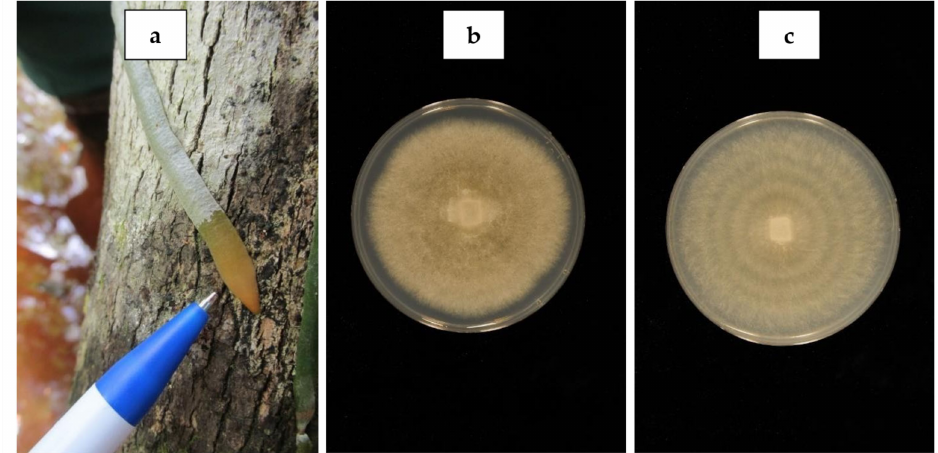
Figure 6. Campylocentrum pachyrrhizum pelotons within the bronze-colored growing root tip were isolated from two separate individuals ( a ). Isolates from these samples were Ceratobasidium 390 ( b ) and Ceratobasidium 392 ( c ). Photos b and c are courtesy of Mike